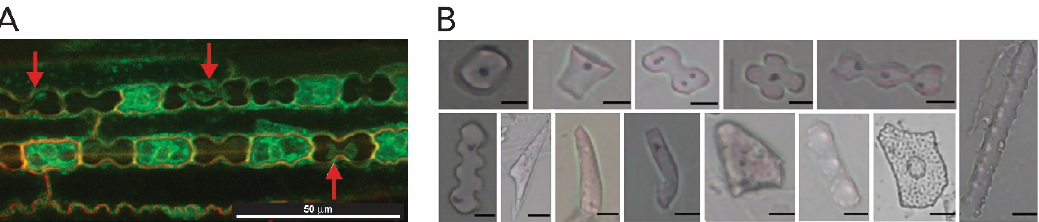
Figure 16. Silica bodies in plants. ( A ) Fluorescence microscopy of silica cells. Arrows indicates extra-membranous silica deposition. ( B ) Some examples of phytoliths from herbaceous plants. Scale bar = 10 mm. Image A is reproduced from [115] and image B is reproduced from [116], both with permission from John Wiley and Sons.